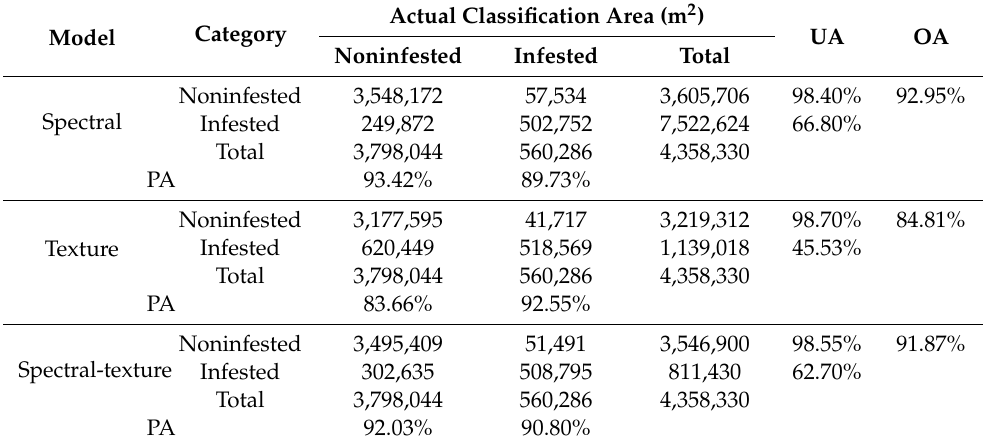
Table 6. Error matrices for classification maps generated by binary logistic regression (BLR) models for the whole study